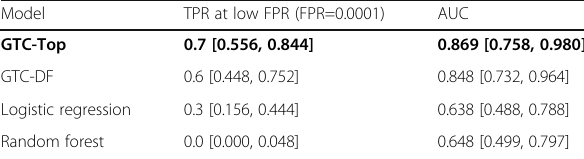
Table 1 (abstract 000205). Performance of models with 95% CI in square brackets